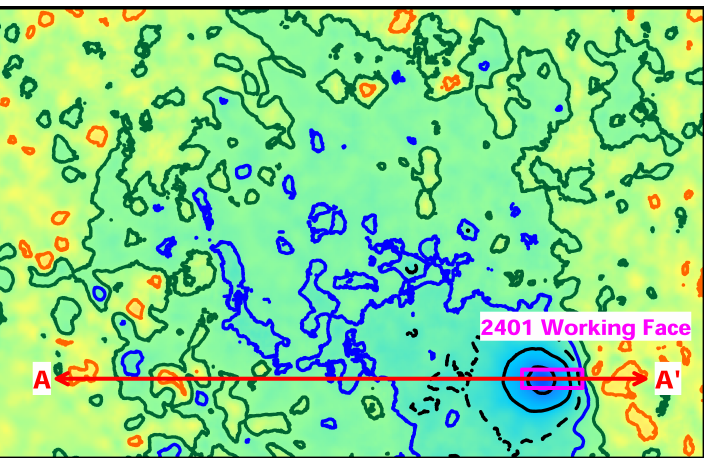
Figure 14. Profile line AA’ along the strike of the 2401 working face.